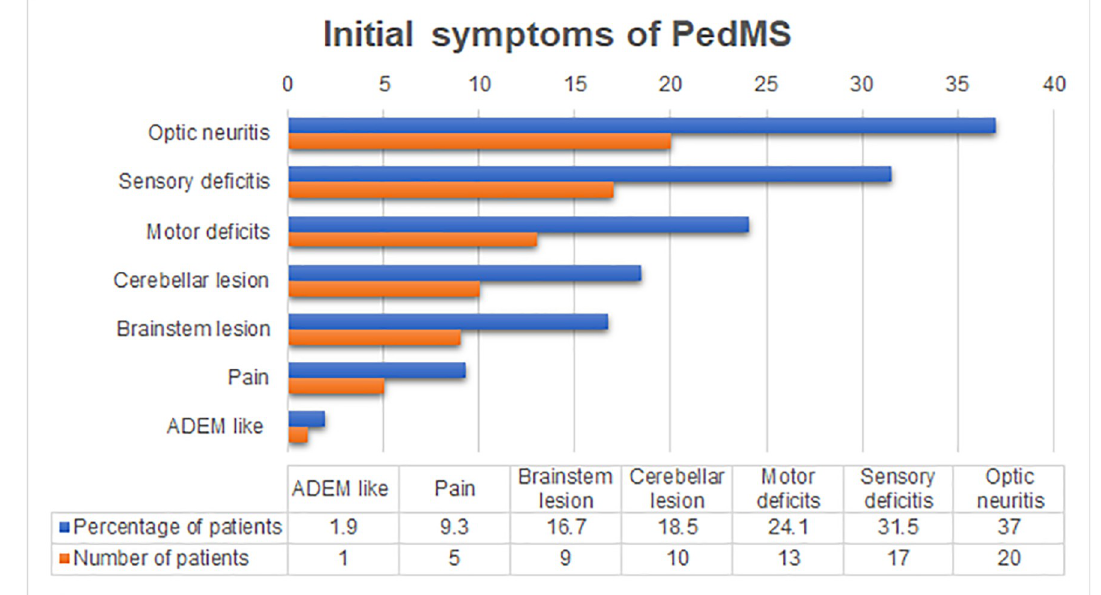
Fig 1. The frequency of initial symptoms in patients diagnosed with PedMS. Optic neuritis was the most frequent initial symptom, present in more than 35% of diagnosed cases, while certain symptoms such as ADEM like symptoms and hearing loss were present in less than 5% of cases. Abbreviations: PedMS–pediatric multiple sclerosis; ADEM—acute disseminated encephalomyelitis.